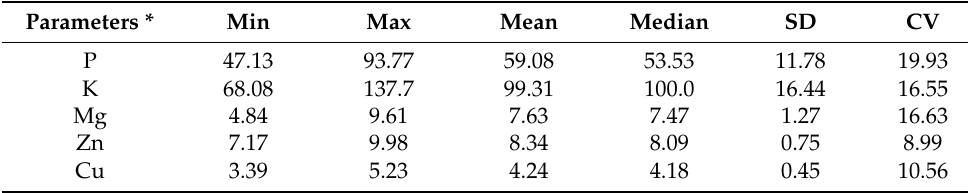
Table 2. Content of available forms of macro- and microelements ( n =